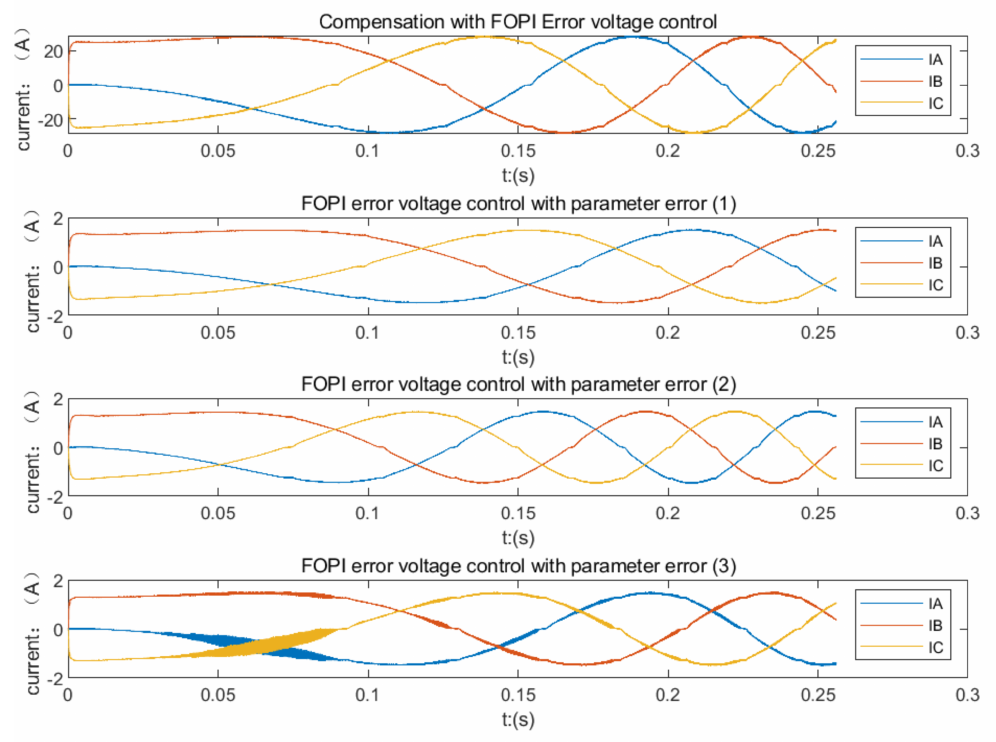
Figure 23. The three-phase current response of the optimal FOPI error voltage control in the error motor